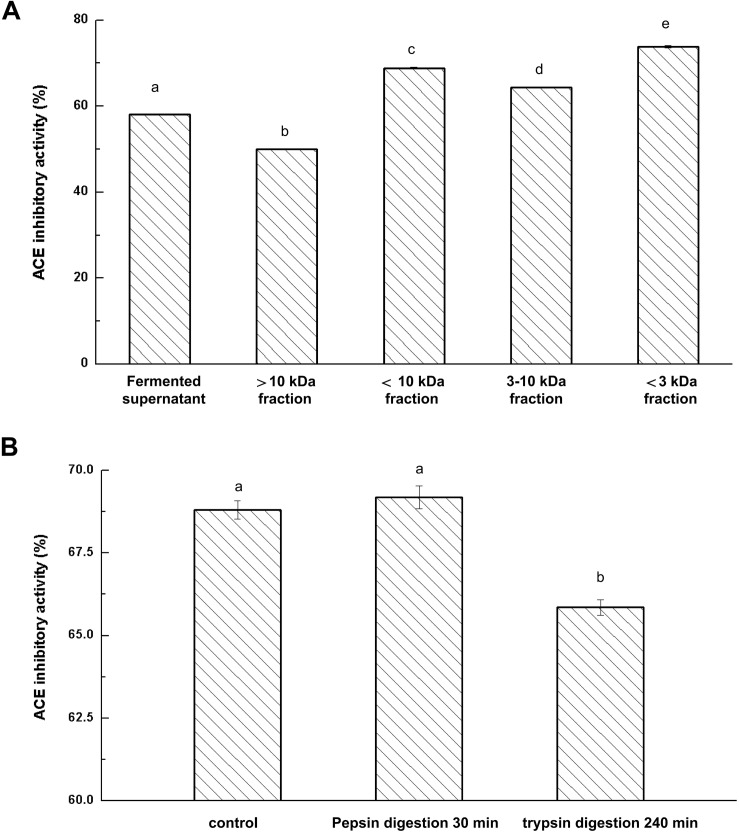
Effects of ultrafiltration (A) and Enzyme hydrolysis (B) on ACE-inhibitory activity of fermented milk; The column data with different letters means significant difference (α = 0.05).